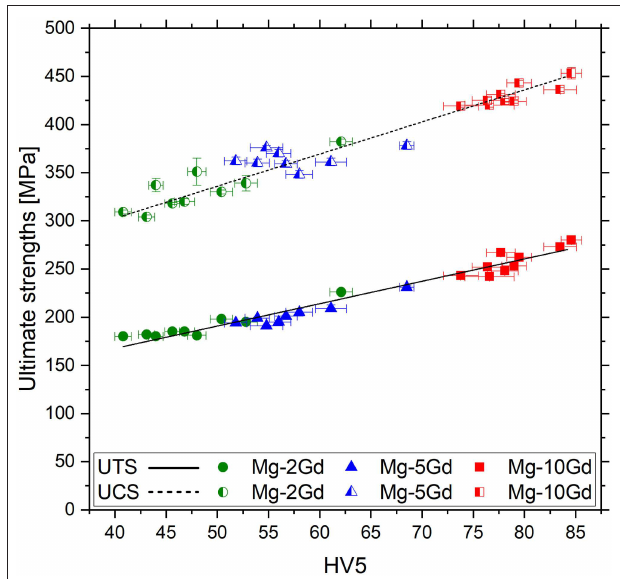
FIGURE 11 | Correlation between UTS/UCS and Vickers hardness. UTS denoted by solid lines and symbols. UCS denoted by halvedsymbols and dashed lines. Error bars are standard deviations.